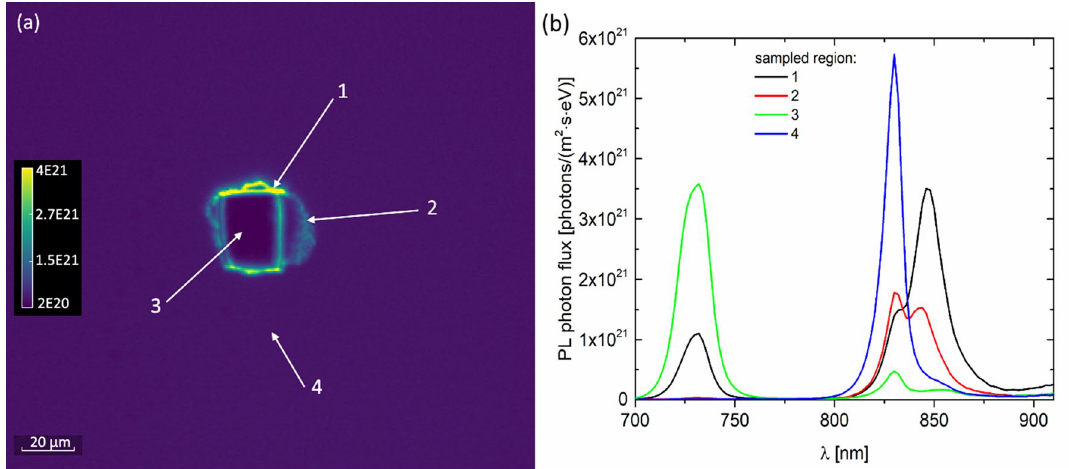
Figure 3. ( a ) A magnified single pinhole defect flux map at 846 nm and 77 K. A strong FB defect emission is observed around the edge region of the pinhole. ( b ) A sampling of the full PL spectra at several spots as labeled in ( a ).